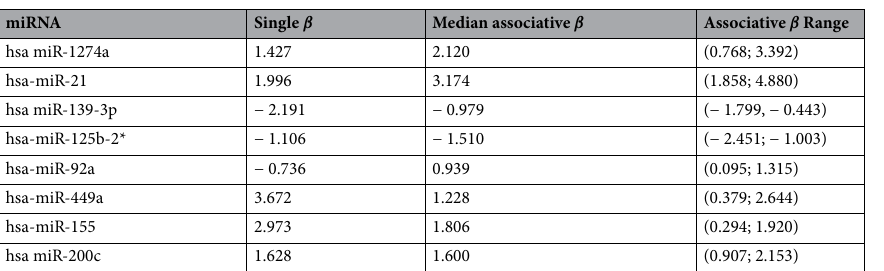
Table 3. Single (i.e. the estimated value of a β coefficient when considering a single miRNA in the logistic model) and associative (i.e. the different values that a miRNA specific β coefficient takes in each of the SWAG models in which it is present) coefficients (median values and range) for the eight most frequently selected miRNAs.